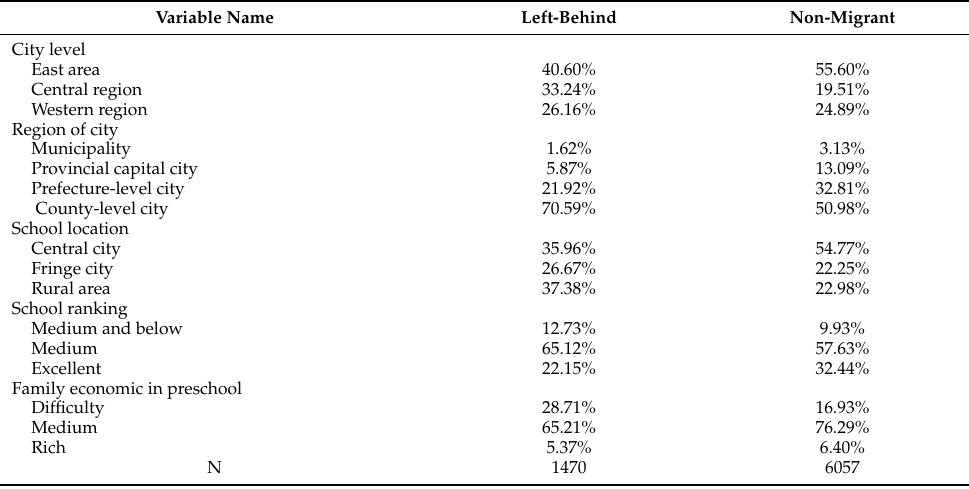
Table A1. Descriptive statistics of the distribution of children in cities